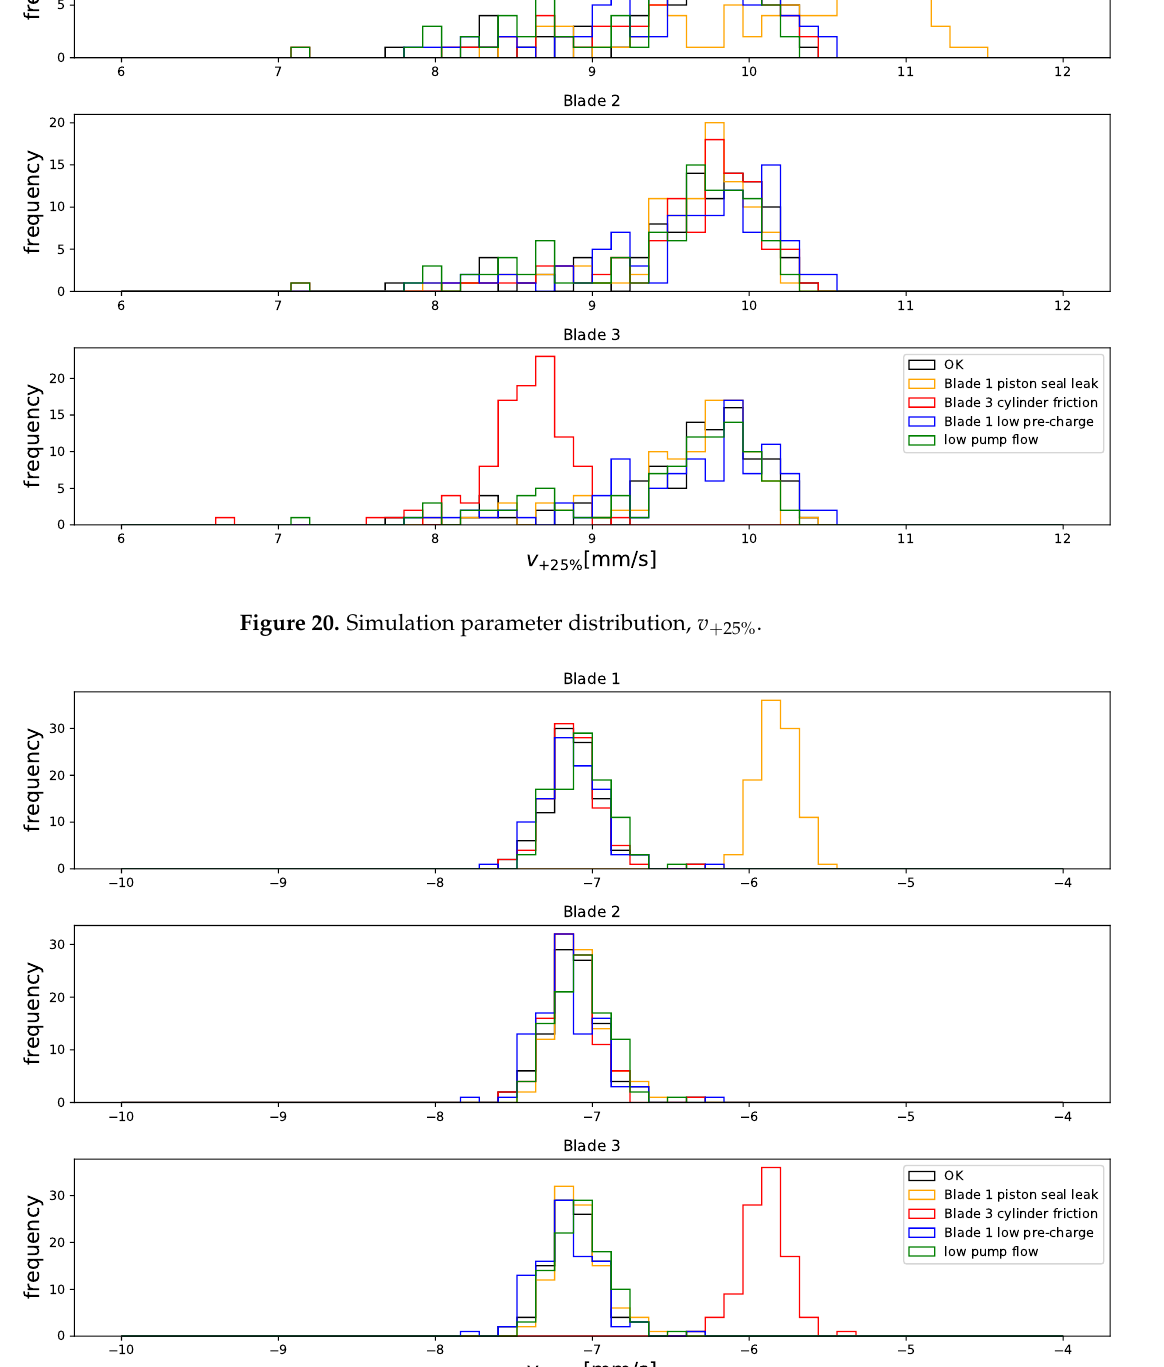
Figure 21. Simulation parameter distribution, v − 25%